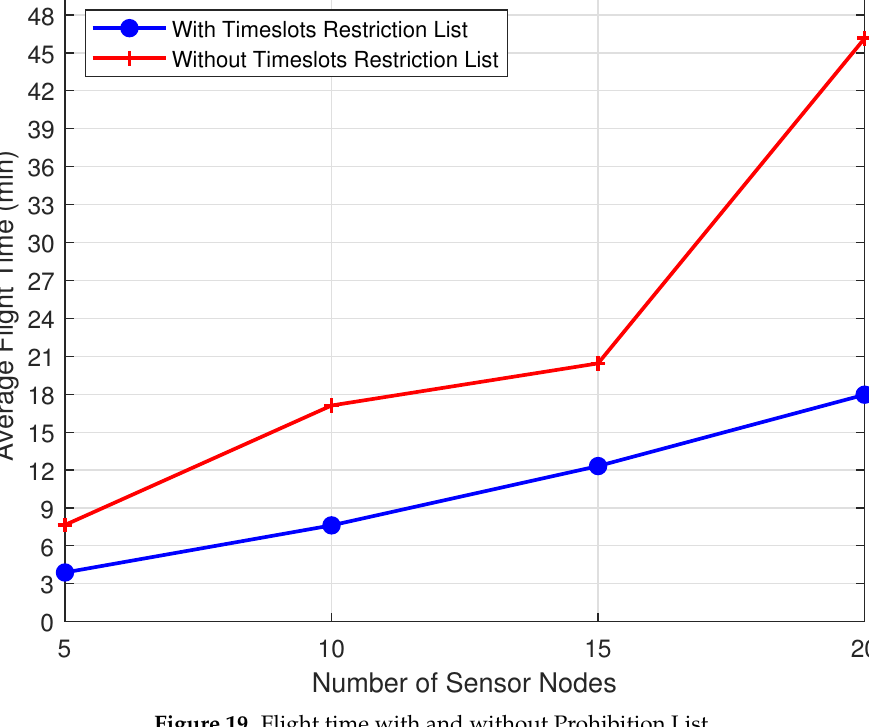
Figure 19. Flight time with and without Prohibition List.